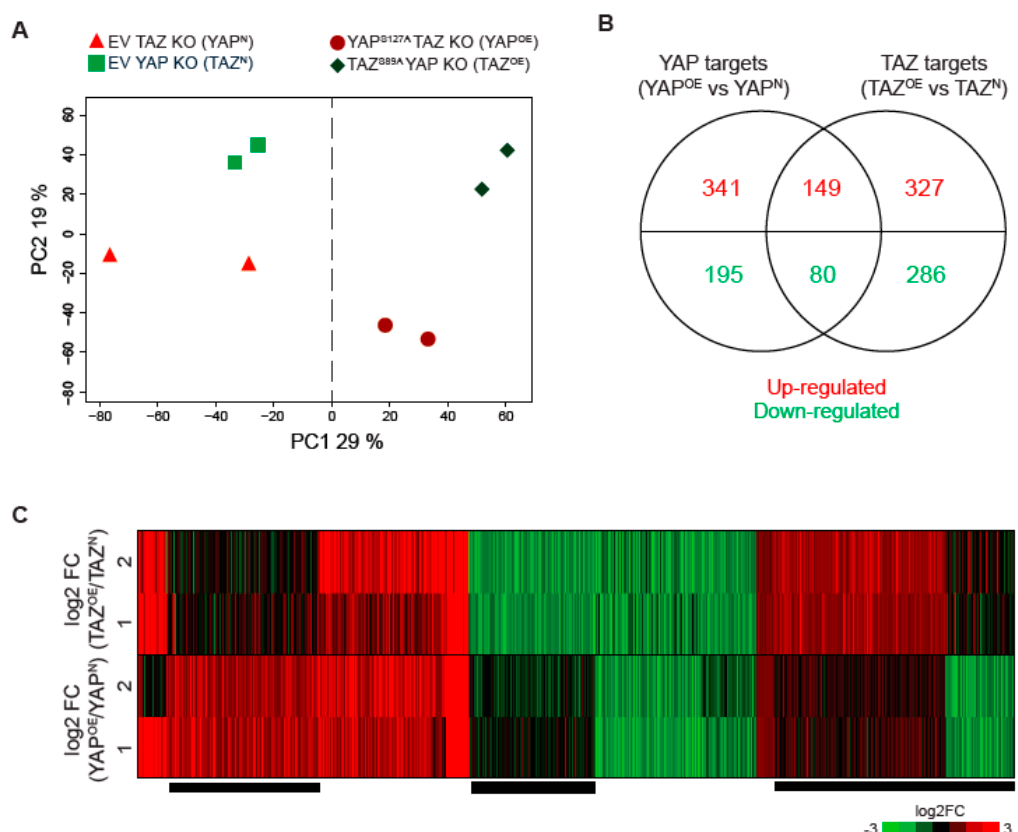
Figure 2. YAP- and TAZ-regulated transcriptional targets. ( A ) The PC1 vs. PC2 plot from the Principal component analysis (PCA) on the RNA-seq data using NOI-seq R package [17]. ( B ) A Venn diagram showing the numbers of transcripts that were up- or down-regulated by YAP overexpression in TAZ KO cells (left circle in the Venn diagram, YAP targets) and TAZ overexpression in YAP KO cells (right circle in the Venn diagram, TAZ targets). ( C ) A heatmap of k-means clustering of the differentially expressed transcripts (DETs) which are the union of YAP and TAZ targets. Each row corresponds to a log 2 fold change (FC) of overexpression (OE) with respect to endogenous (N) samples, and each column corresponds to a DET. Numeric row names, 1 and 2, indicate respective KO clone 1 and clone 2. Red and green colour indicates activated and repressed transcripts in both ( B ) and ( C ). Black lines along the bottom indicate a subset of DETs showing distinct expression patterns between TAZ- and YAP-regulated transcripts.